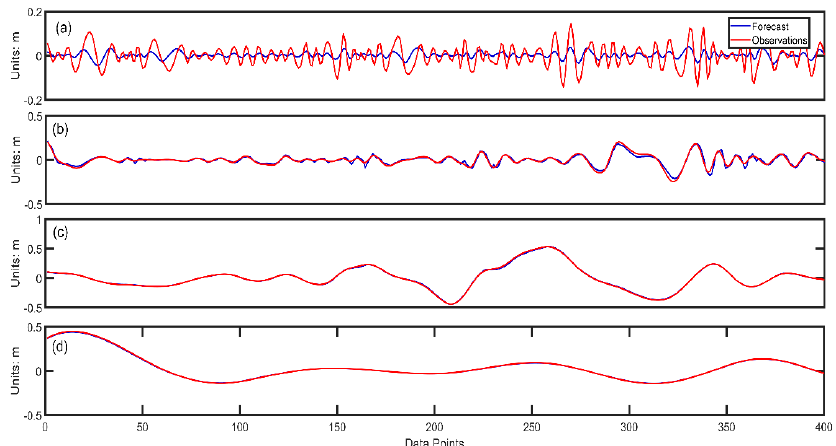
Figure 9. Comparison of (blue) significant wave height forecasts of ( a ) the second ( b ) third, ( c ) fourth, and ( d ) fifth intrinsic mode functions.